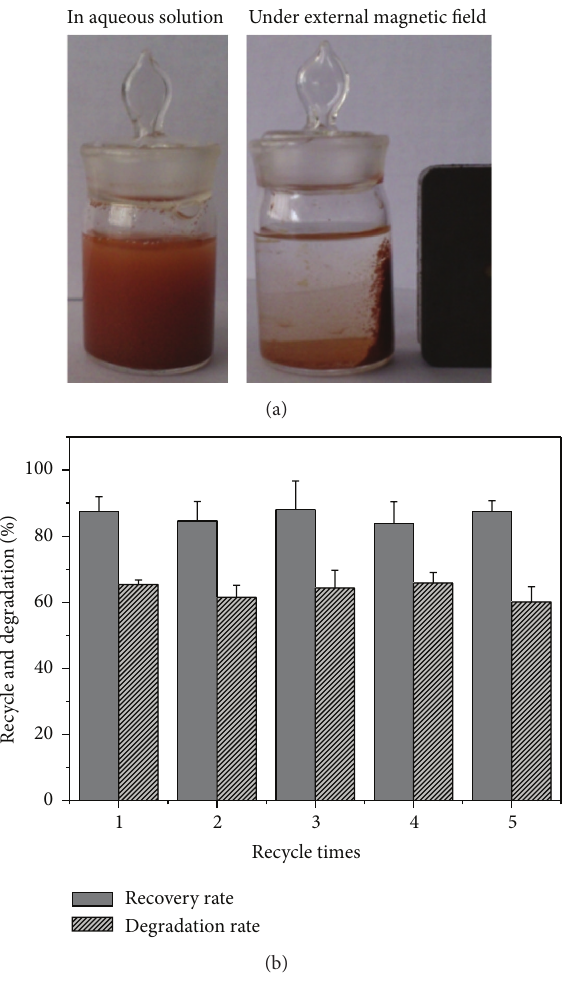
Figure 6: (a) The recoverability of Fe 3 O 4 @SiO 2 /Bi 2 SiO 5 composite under external magnetic field (b) the stability and recoverability of Fe 3 O 4 @SiO 2 /Bi 2 SiO 5